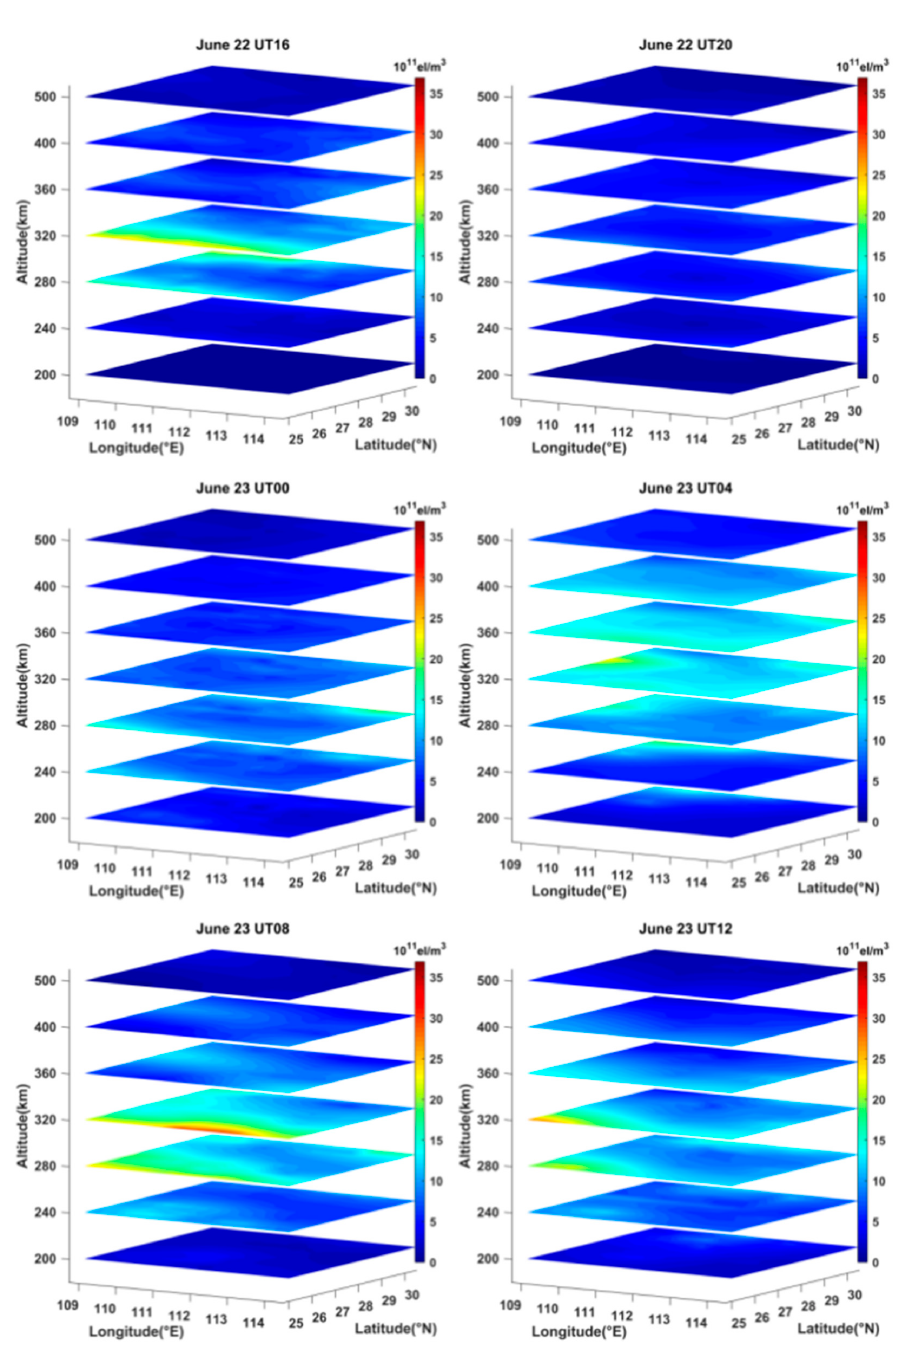
Figure 9. Time -series variation of three-dimensional IED distributions in the reconstructed region on June 22 and 23, 2015.